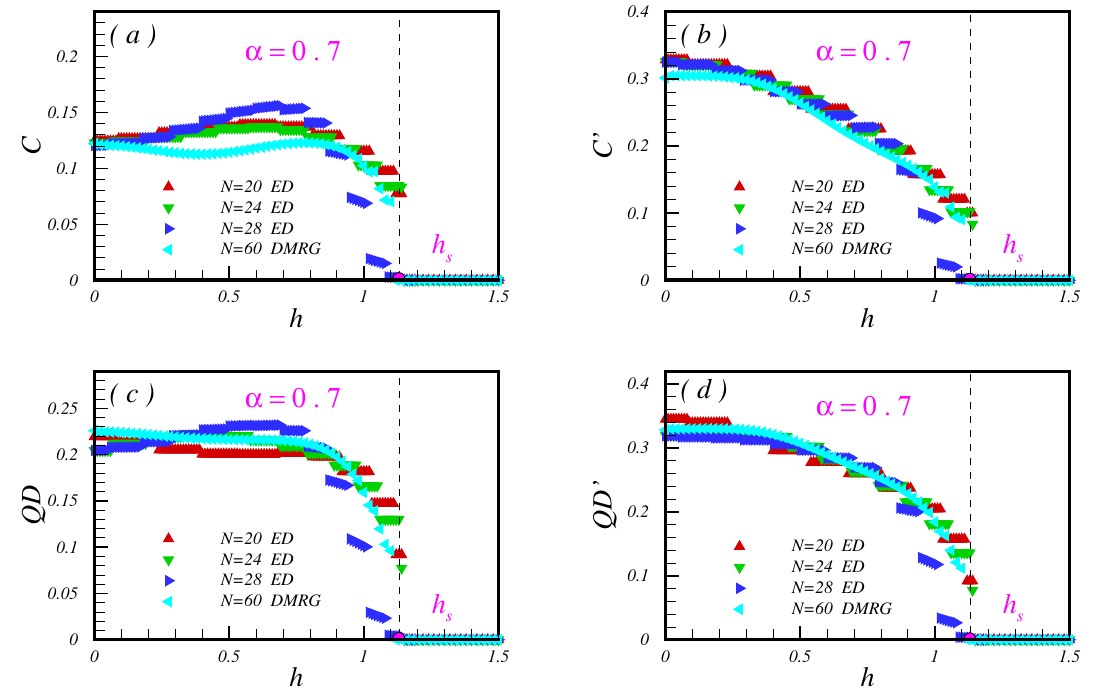
Figure 4. The concurrence and the QD between pair of spins on bonds with exchange coupling J ( a , c ) and J ′ ( b , d ) versus the TF. Lanczos results are presented for α = 0.7 and clusters with N = 20, 24, 28 spins. DMRG results presents for N = 60